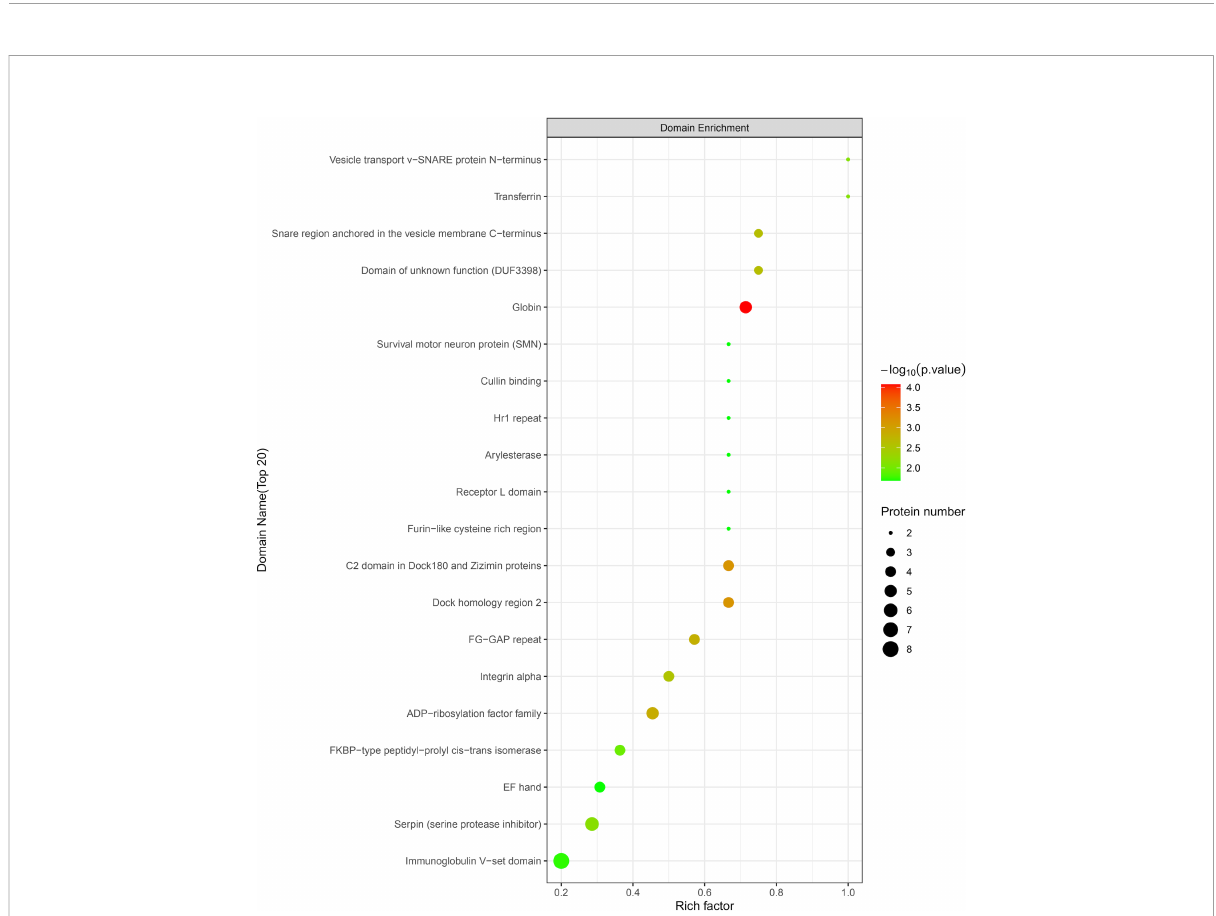
FIGURE 6 LIRA/Model differential protein domain analysis diagram (n=3). The horizontal axis is the rich factor (Rich factor ≤ 1), and the vertical axis represents the statistical results of DEPs under each domain classi fi cation. The color of the bubbles indicates the signi fi cance of enrichment under the corresponding domain classi fi cation, the P value is calculated by Fisher ’ s Exact Test, and the color gradient indicates -log10 (P value). The redder the color, the smaller the P-value, and the higher the signi fi cance level of the enrichment under the corresponding domain classi fi